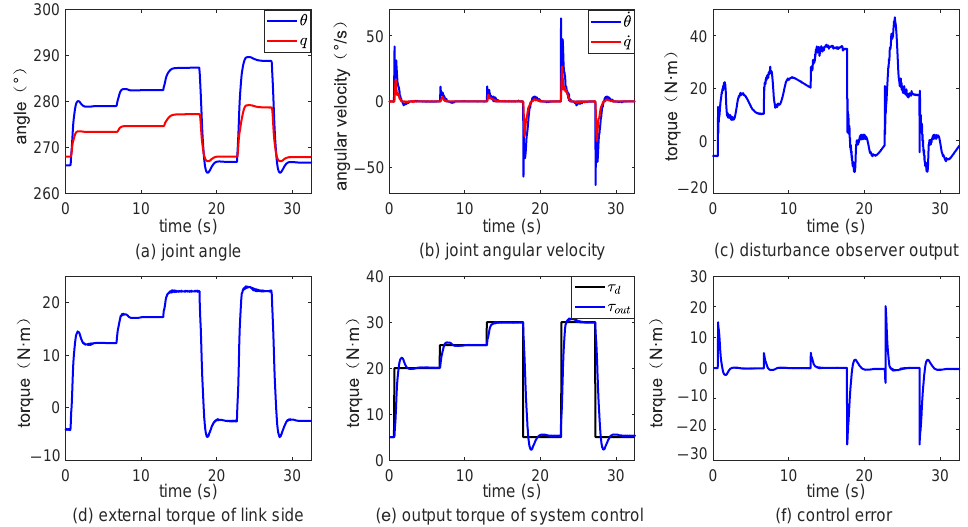
Figure 18. The output results of the physical system based on the resonance proportional force control. Resonant proportional control is used for force control on the link side. Elastic feedback gain is used to change the resonance ratio and configure the pole of the characteristic equation of the closed-loop system to suppress the resonance. Nonlinear disturbances are estimated using an acceleration-based model of external moments and compensated for by a force reaction system to achieve link force control. Numerical simulation results prove the effectiveness of the force control